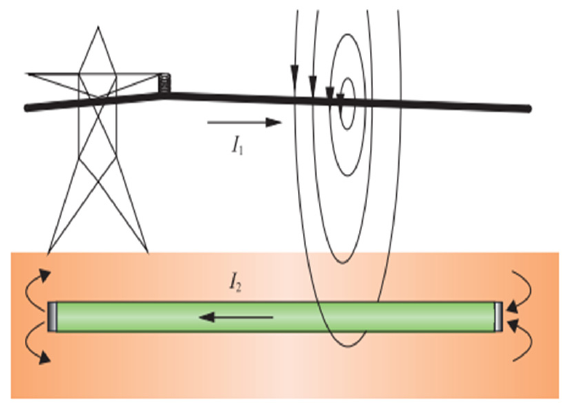
Figure 1. Induced effects of pipelines and AC transmission lines.